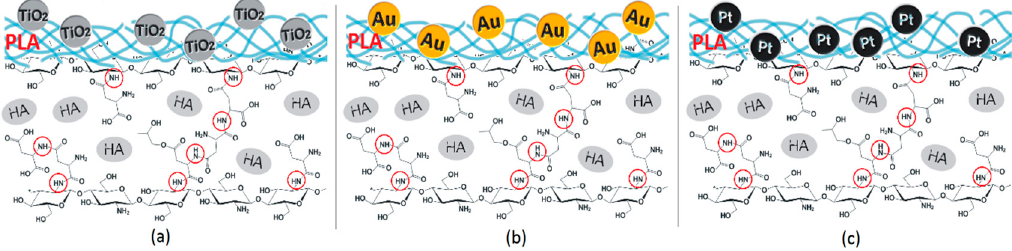
Figure 3. ( a ) 3D hybrid scaffolds’ chemical structure doped with TiO 2 NPs; ( b ) 3D hybrid scaffolds chemical structure doped with Au NPs; and ( c ) 3D hybrid scaffolds doped with Pt NPs.